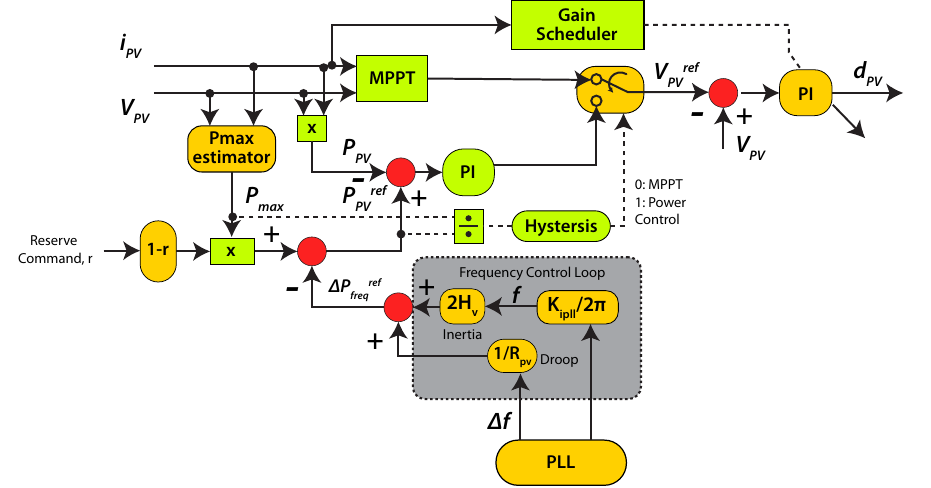
Figure 12. PV system inertia emulation and primary frequency